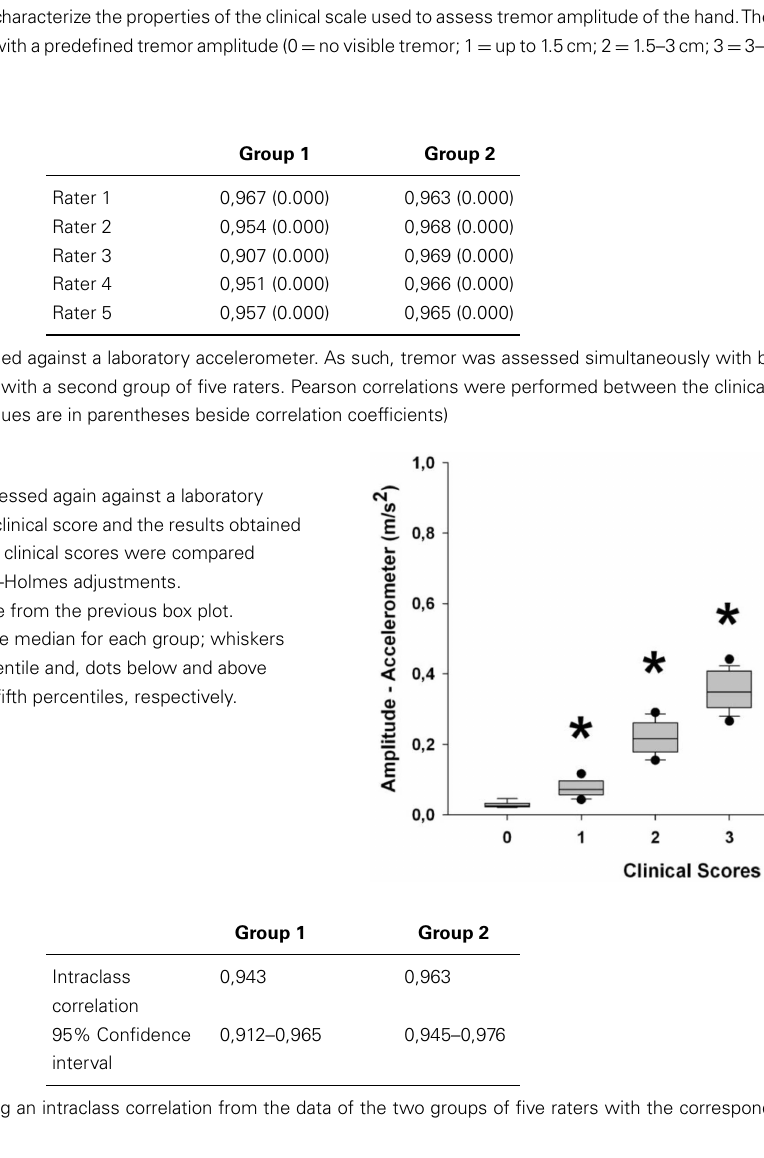
Table 3 |Table describing the results from the validation of the clinical scale used in Part 2 of the